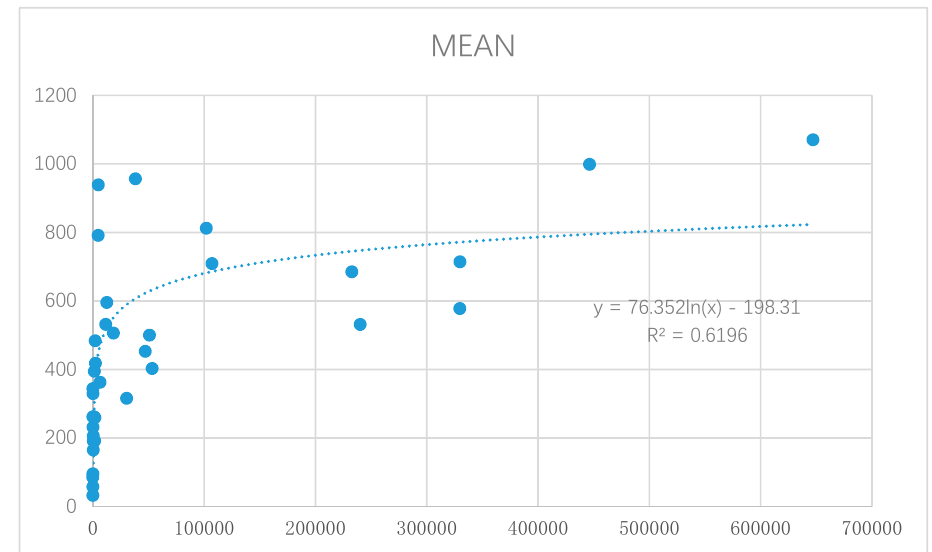
Figure 4. Urbanization intensity (light inversion) in central Beijing in the years 1992, 2000, 2008, and 2016.